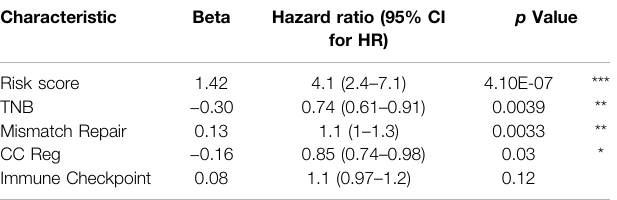
TABLE 4 | Multivariate Cox regression